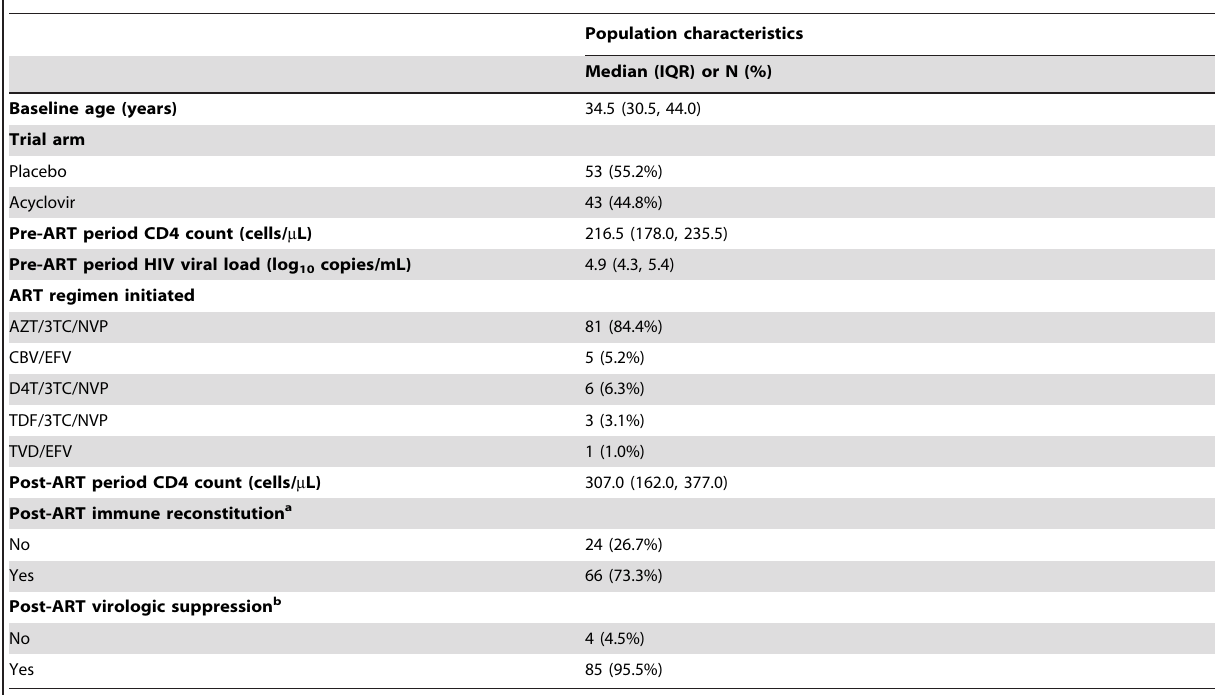
Table 1. Characteristics of the female study population (N